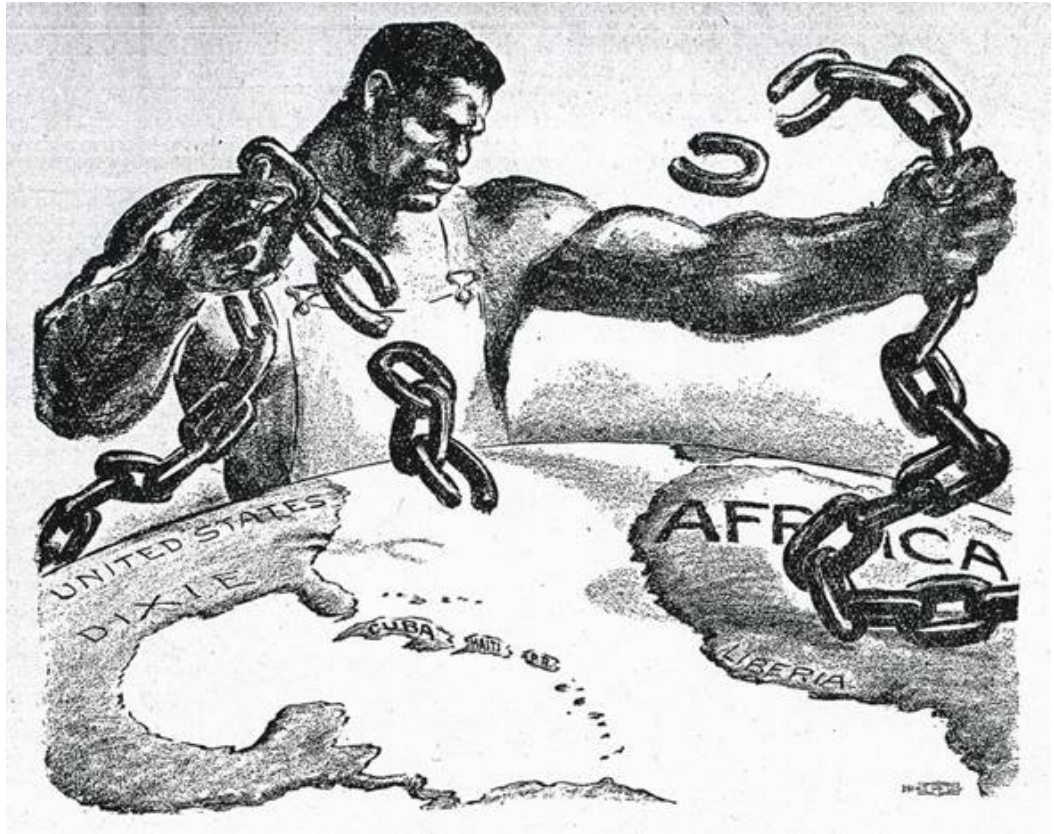
Cover illustration, American Negro Labor Congress: A Call to Action , 1925 (Courtesy: Tobias